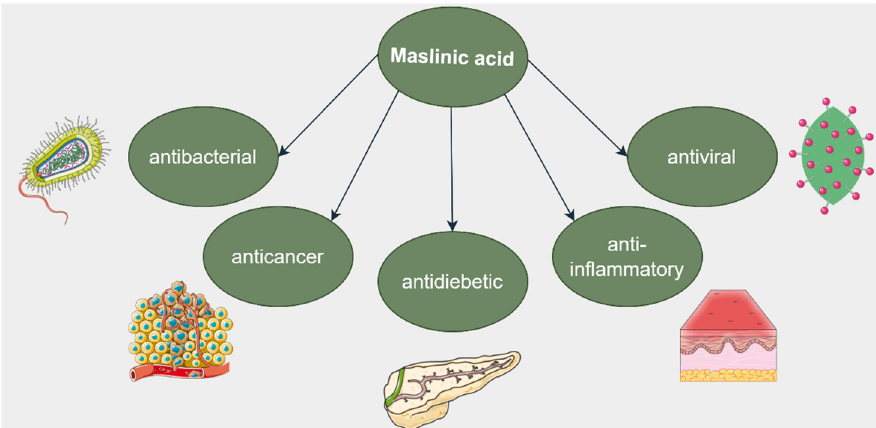
Figure 14. Structure of maslinic acid.